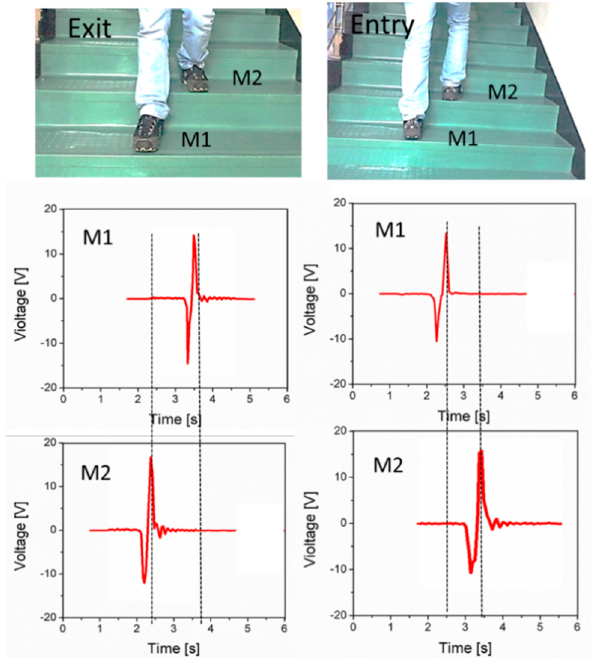
Figure 8. People counting application of the proposed device, in the Exit scenario: M2 is pressed prior to M1 the voltage spikes occurs at 2.5s for M2 and 3.5s for M1 in the time domain. In the Entry scenario: M1 generates voltage spike at 2.5s while M2 at 3.5s.